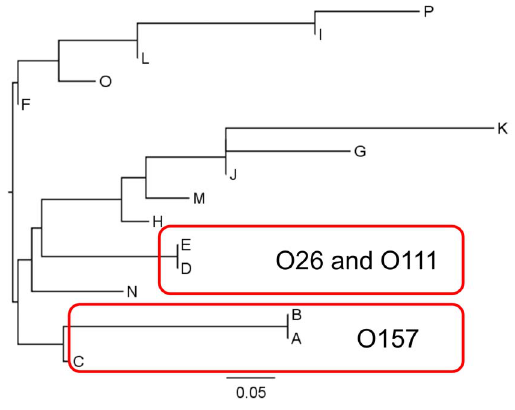
Figure 2. Cluster analysis for E. coli strains with selected biomarkers. Phylogenetic tree according to the binary graph made by actual analysis in Table 4 is shown. A to P indicate the E. coli groups classified by the theoretical mass patterns of biomarker protein peaks in Table 3.